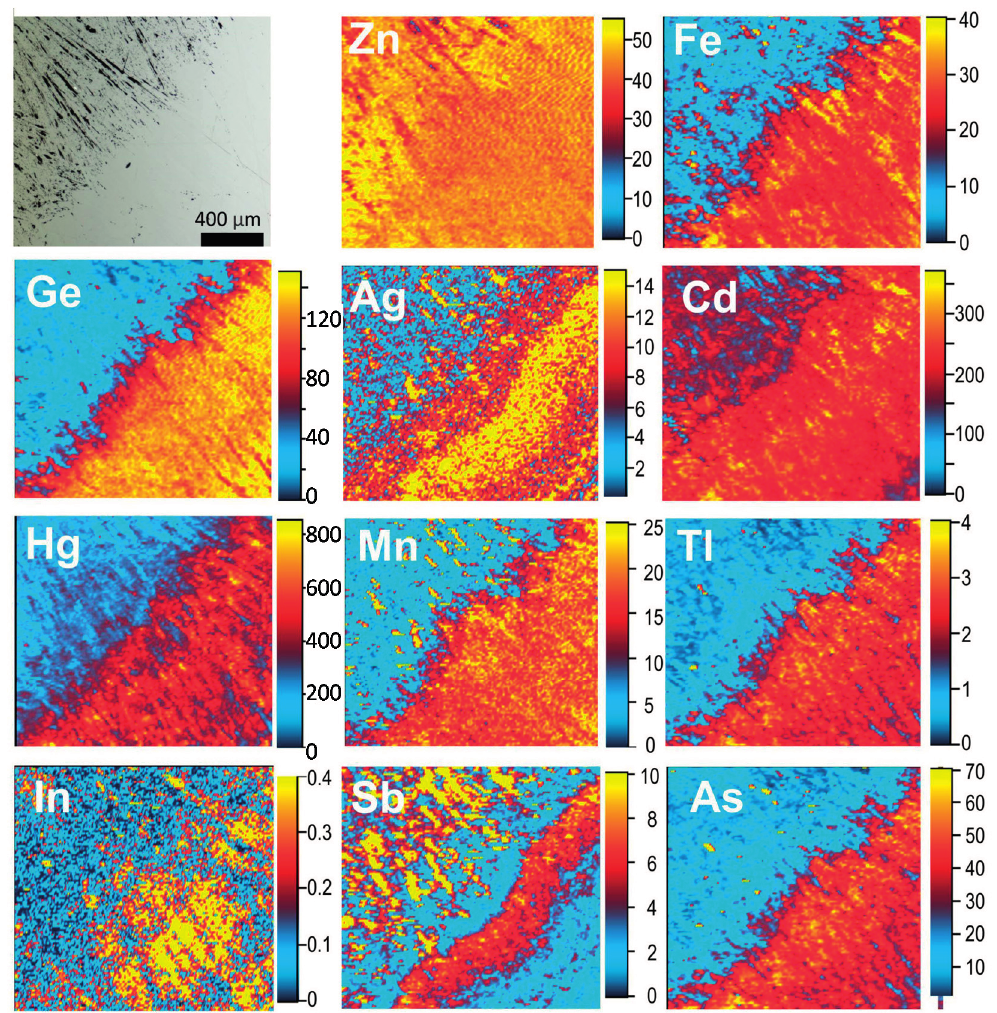
Figure 1. Reflected light image of sphalerite from the Tres Marias Zn deposit, Mexico (top left) and LA-ICP-MS element maps across the boundary between (Ge-Fe)-rich and (Ge-Fe)-poor areas. Scales in counts-per-second × 10 3 (except Zn and Fe: × 10 6